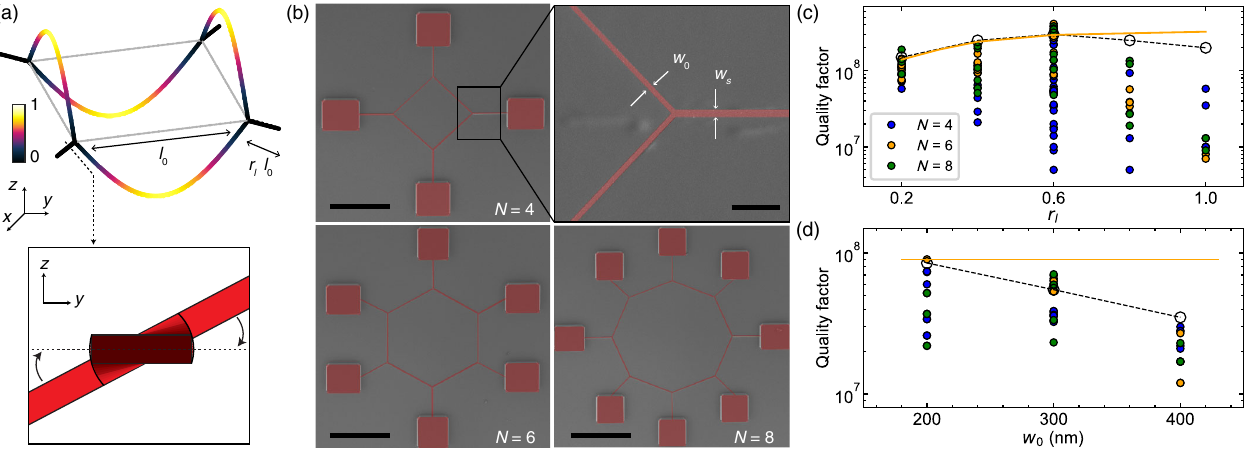
FIG. 2. Ultrahigh- Q perimeter modes. (a) FEM simulation of the fundamental perimeter mode with an inset showing the generation of torsional deformation of the tethers. (b) False-colored scanning electron micrographs of polygon Si 3 N 4 strained resonator devices with 0 . 6 , w 200 nm, and 20 nm thickness (scale bars correspond to 500 μ m). Top right of (b) shows an enlarged l 0 ¼ 700 μ m, r 0 ¼ l ¼ junction of a stress-preserving square resonator (scale bar corresponds to 1 . 5 μ m). (c) The effect of tether length ( r with l 0 ¼ 250 μ m, w 0 ¼ 300 nm, and 20 nm thickness. Blue, orange, and green data points represent square, hexagon, and octagon resonators, respectively. (d) The effect of polygon width ( w 0 ) on the Q for samples with l 0 ¼ 100 μ m, r Open circles (joined by a dashed line) are FEM simulations and orange line is the Q computed from Eq.